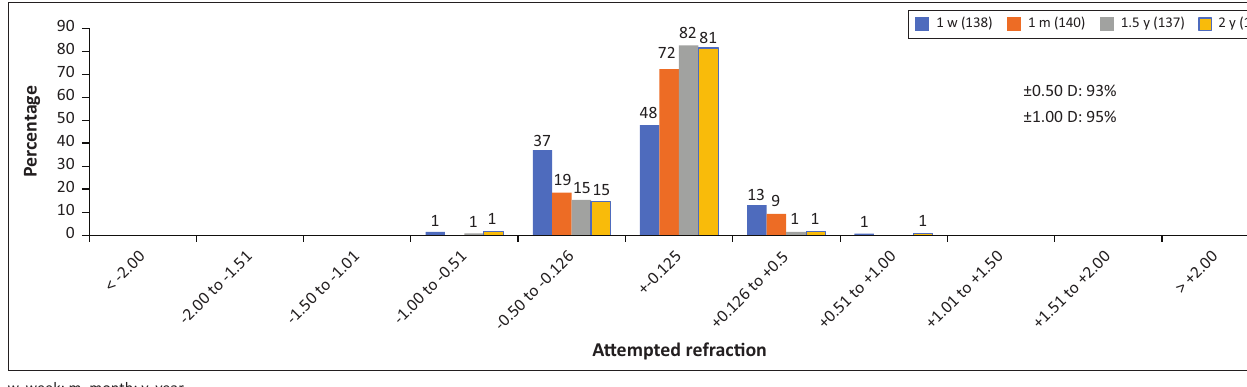
FIGURE 2: Predictability of refractive outcome in term of spherical equivalent within ±0.5 and ±1.0 at 1 week, 1 month, 18 months and 2 years of follow-up. Refractive outcome in terms of percentage within attempted refraction.